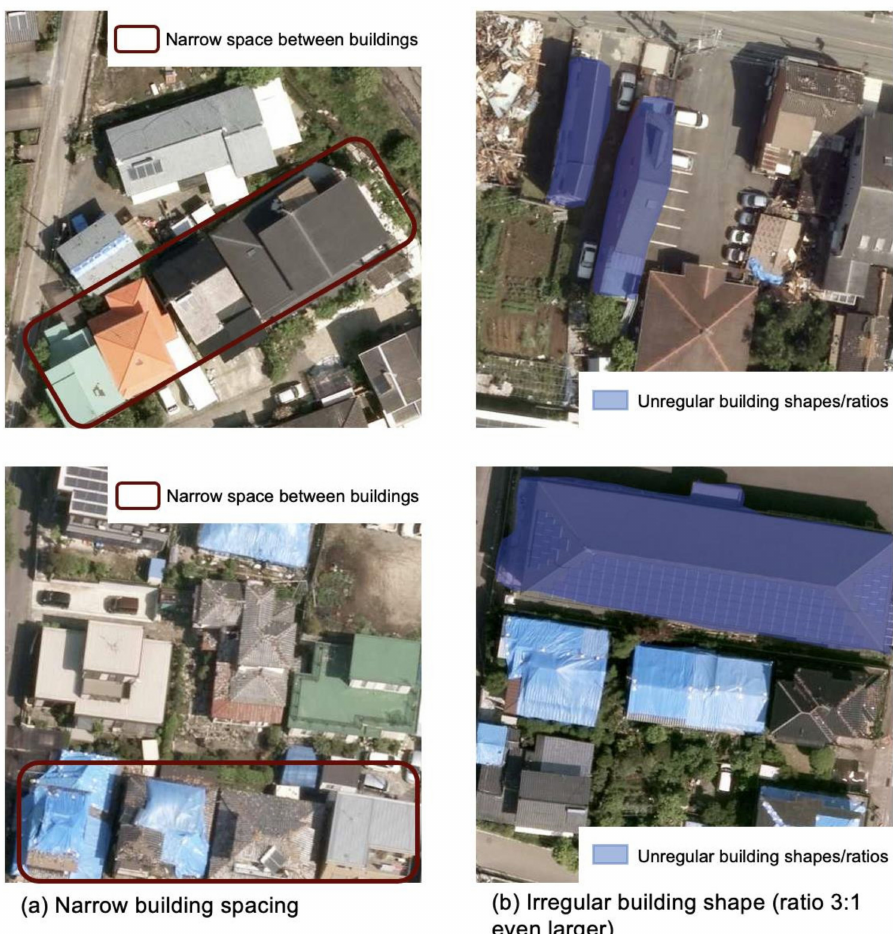
Figure 15. Two examples of buildings that were difficult to detect by the original RPN